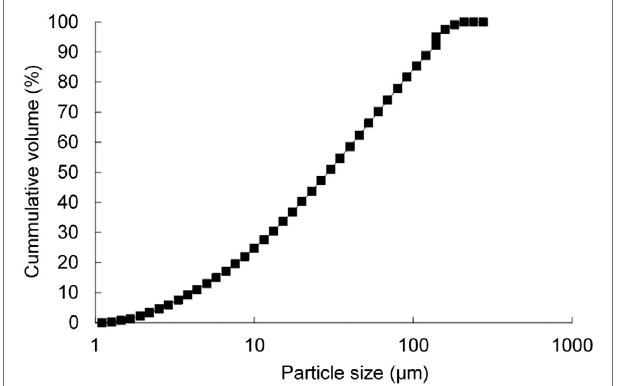
FIGURE 2 | Particle size distribution of milled waste glass